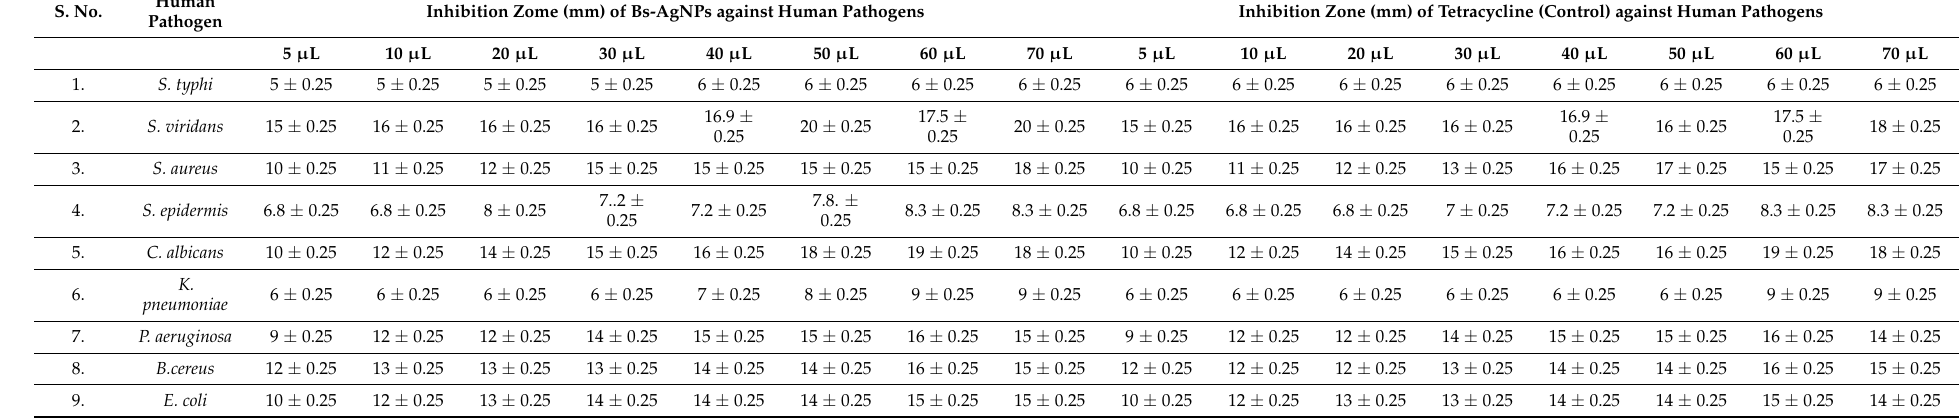
Table 3. Antibacterial activity of synthesized Bs-AgNPs vs. tetracycline (control) against human